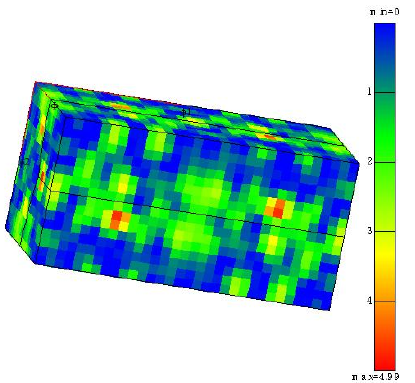
Figure 10. Orientation distribution diagram of Al-Mg alloyed additive.